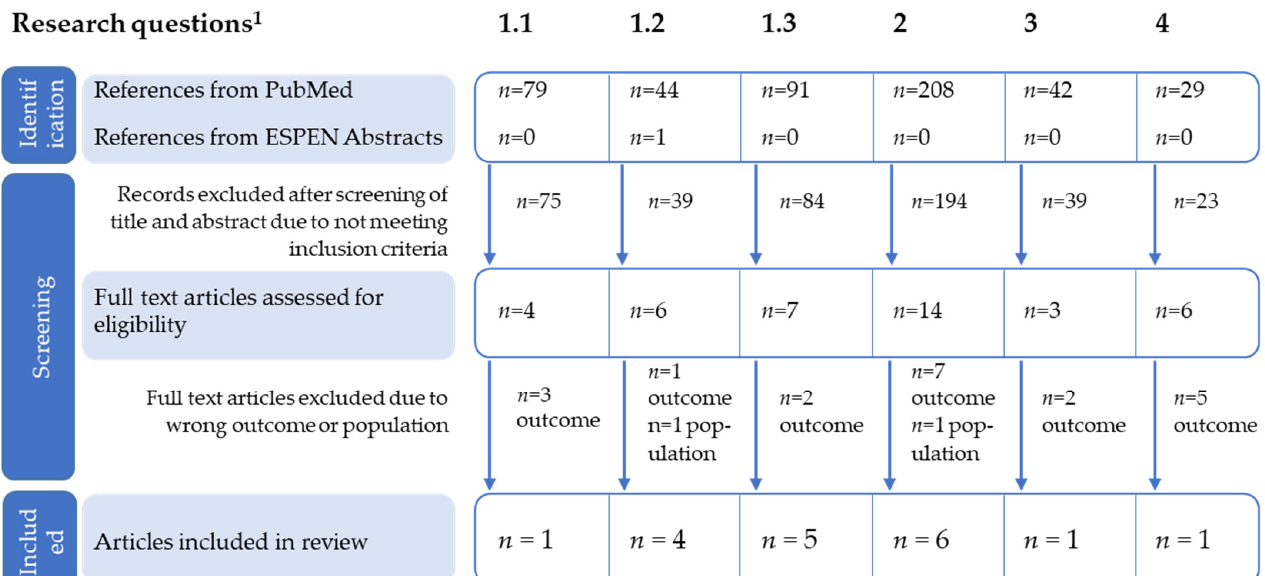
Figure 1. Flow chart of the identification of new studies according to each research question. 1 Six different searches were conducted in total (three searches for research question (RQ). RQ1: How should low-intake dehydration be identified in older persons? 1.1 by osmolality, 1.2 by osmolarity, 1.3 by clinical signs and bioelectrical impedance. RQ2: What interven- tions may help to support older persons to drink well and prevent low-intake dehydration? RQ3: How much should older people drink each day? RQ4: What should older people drink each day?